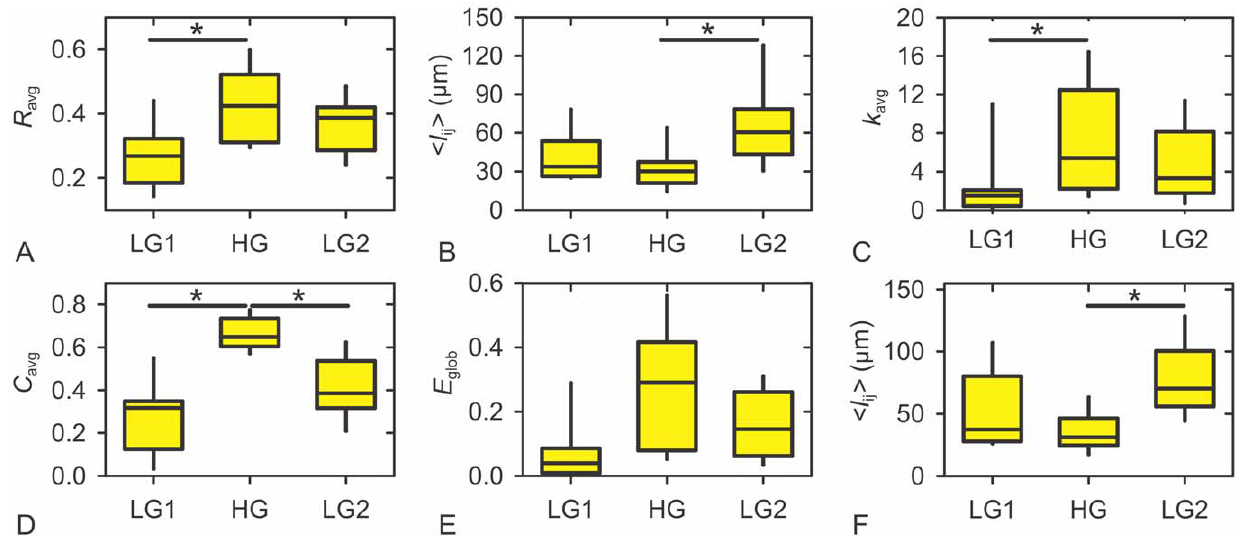
Figure 5. Characteristics of functional networks of beta cells in 9 islets of Langerhans for three of the five regimes analyzed. A The average correlation coefficient. B The average physical distance between connected cells. C The average node degree. D The average clustering coefficient. E The global efficiency. F the average lengths of connections originating from 20% of the cells with the highest degree. In all panels red circles denote the median values, whereas the yellow floating columns signify the broadness of intervals within which the values were detected in